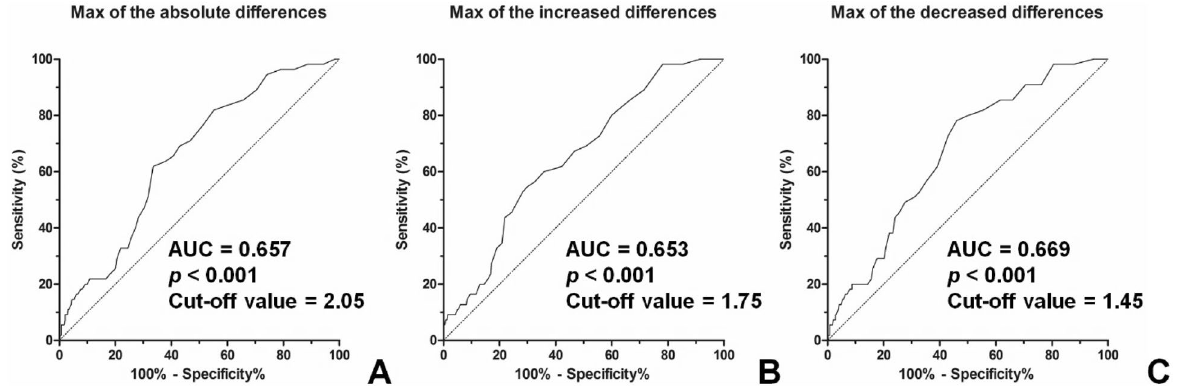
Figure 3. Receiver operating characteristic (ROC) curve for predicting diabetic retinopathy development using inter-visit HbA1c differences. ( A ) The ROC curve of the absolute inter-visit HbA1c level difference, ( B ) The ROC curve of the increase in HbA1c difference, ( C ) The ROC curve of the decrease in HbA1c difference. AUC, area under the